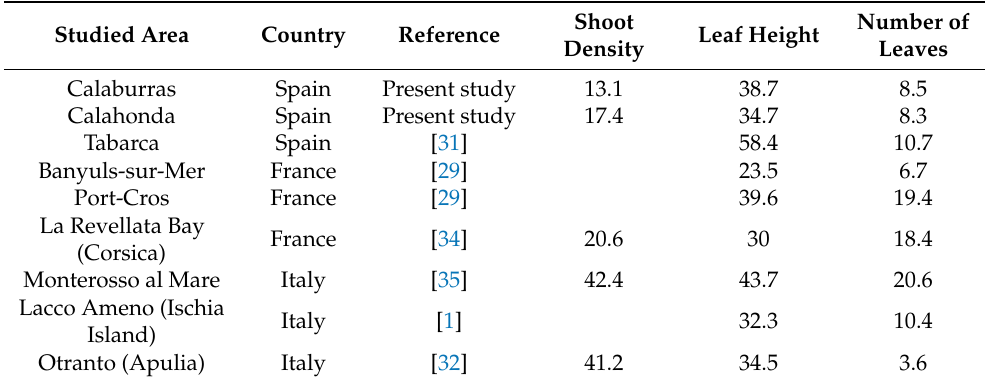
Table 6. Magnitude of intra-annual fluctuations (coefficient of variation, %) in shoot density and phenological parameters of Posidonia oceanica meadows in Calaburras and Calahonda (NW Alboran Sea), as well as in other locations of the Mediterranean Sea. Studied Area Country